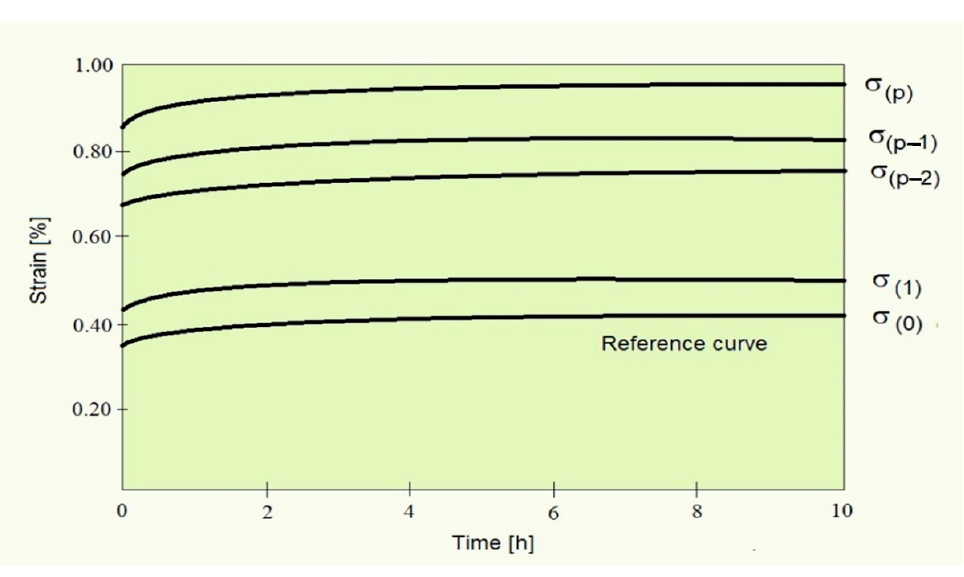
Figure 3. Strain versus time in a creep typical experiment.